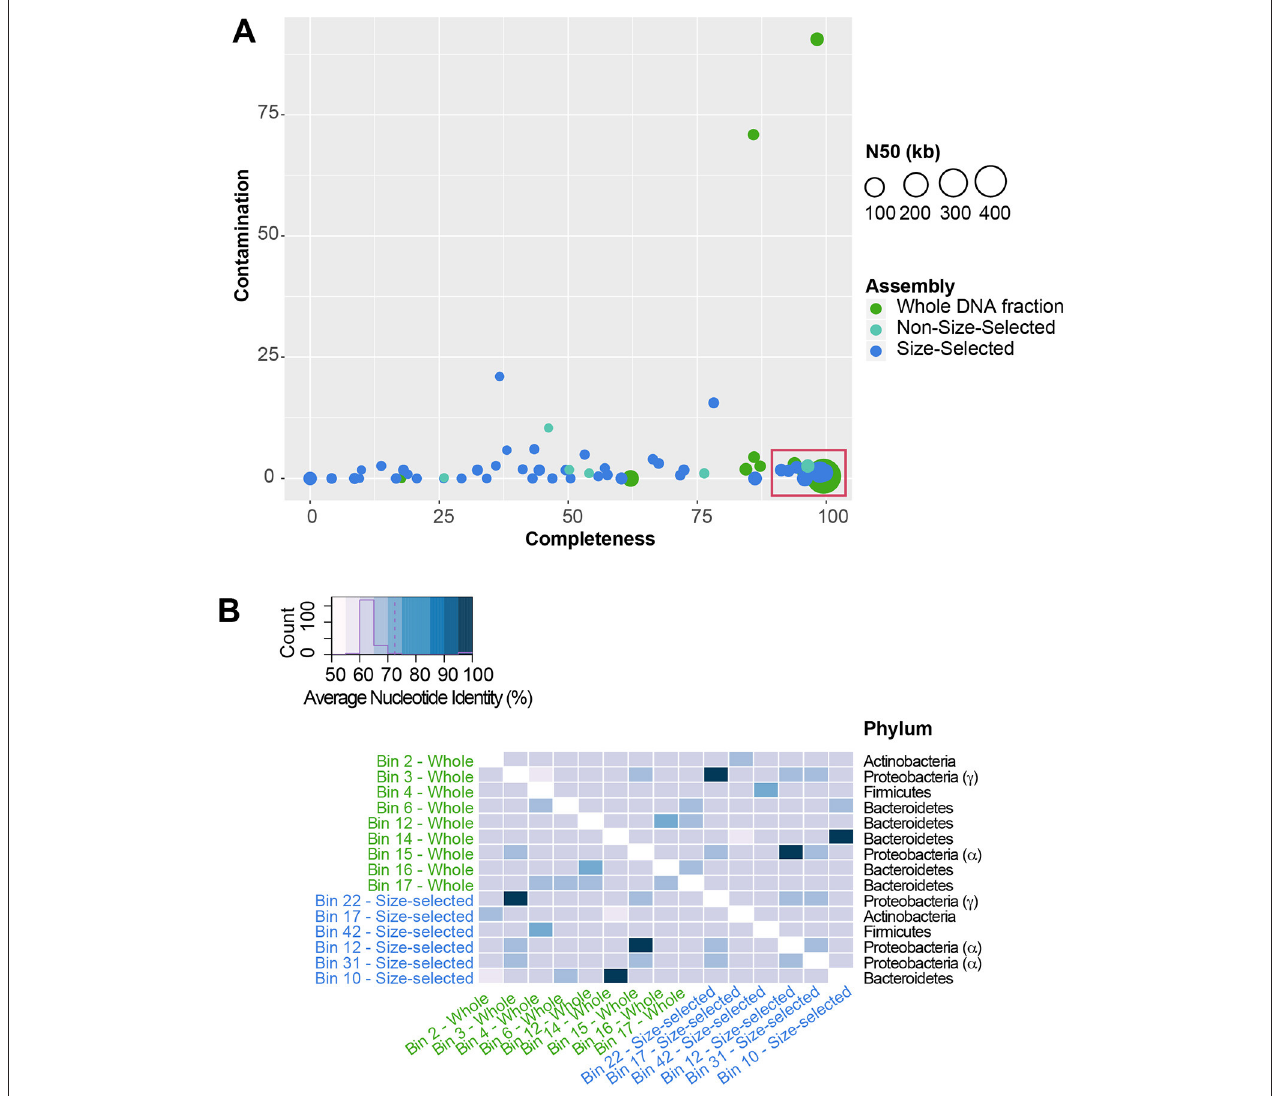
FIGURE 8 | Metagenome-assembled genomes (MAG) within the Illumina-sequenced datasets. (A) Plot showing MAG bin contamination on the y-axis vs. estimated bin completeness on the x-axis. Dots are scaled by the N50 value of the contigs and scaffolds in each MAG, and are color-coded by the sequencing approach. High-quality MAGs used for downstream analysis are indicated by the red box. (B) Average Nucleotide Identity (ANI) of MAGs. Three pairs of MAGs share > 99% ANI, indicating that they are likely from the same population of